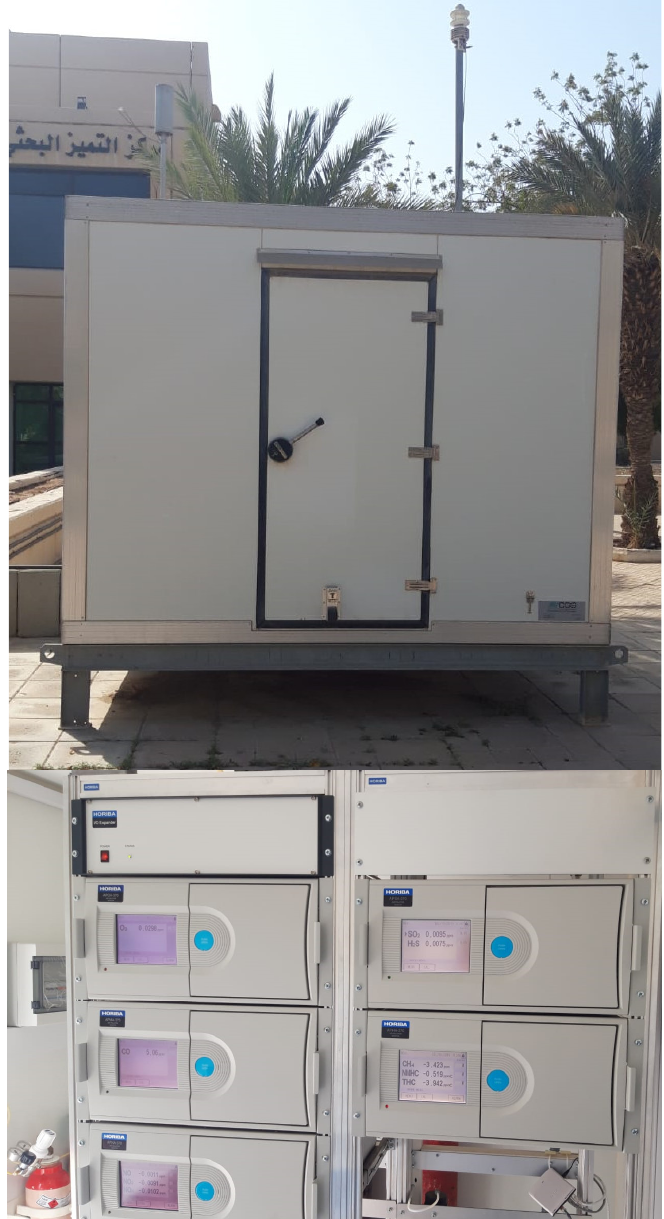
Figure 1. Air quality monitoring station (AQMS): Outside ( top ) and inside ( bottom ) view.